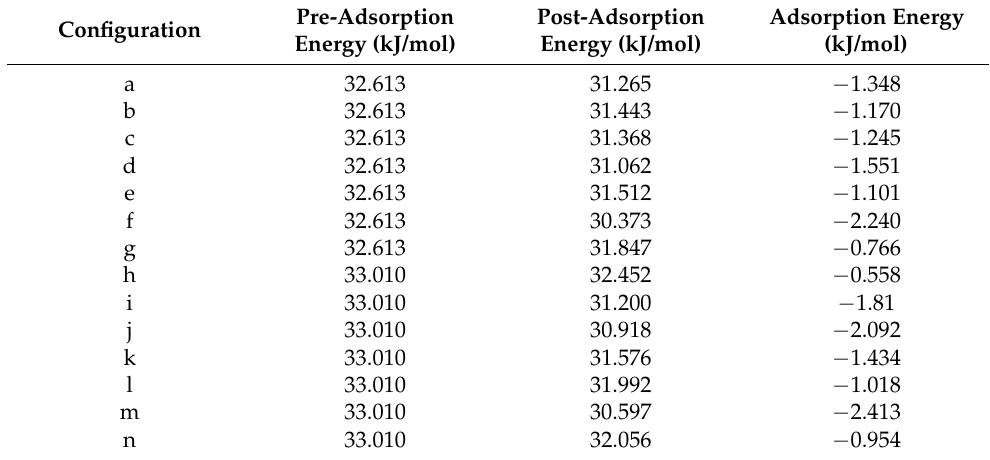
Table 2. Energy changes before and after the adsorption of water molecules in different configurations.